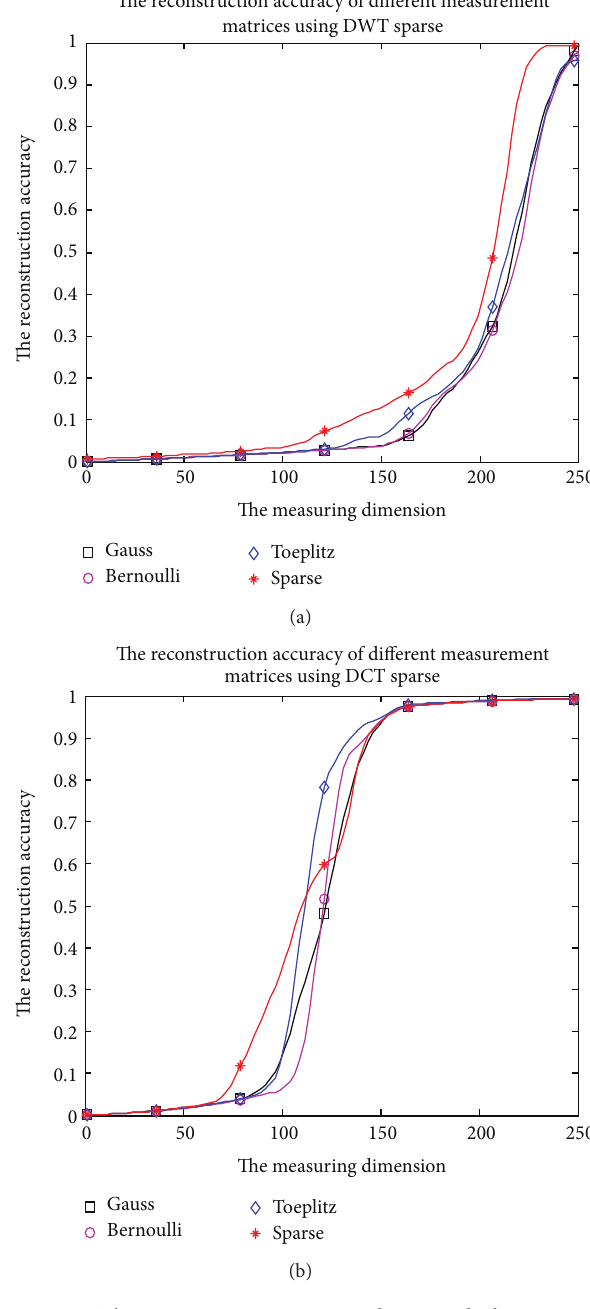
Figure 7: The reconstruction accuracy change with the measure- ment matrices and the dimension 𝑀 of measurement vector 𝑧